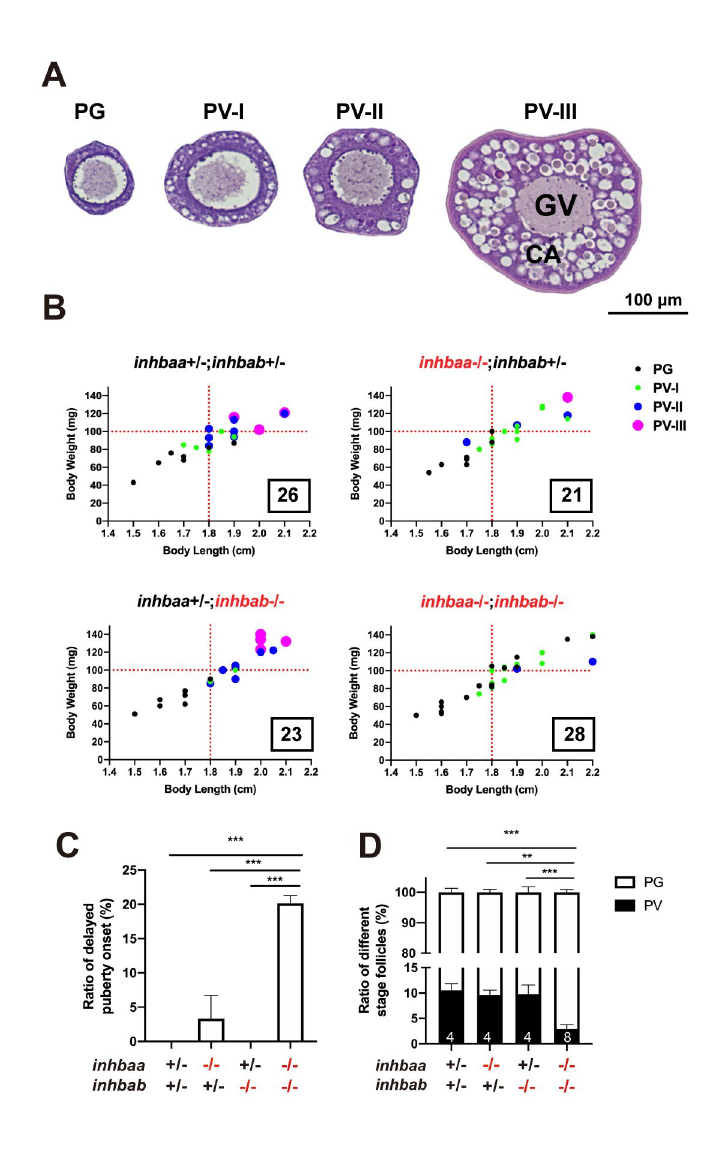
Fig 4. Quantitative analysis for delayed puberty onset in activin β A double mutant ( inhbaa -/-; inhbab -/-). (A) Classification of PV follicles. The PV stage is further divided into three sub-stages according to size and layer number of the cortical alveoli (CA). PV-I, single layer of small CA; PV-II, single layer of large CA; PV-III, multiple layers of large CA. (B) Correlation between PG-PV transition and body size [BL (cm) and BW (mg)]. Dots in different color and size represent different stages of follicles. The number in the box indicates the sample size. (C) Ratios of delayed puberty onset in different activin β A mutants at 45 dpf (n = 3 batches). (D) Follicle composition in the ovary of β A mutants at 45 dpf. Sample size is indicated at the bottom of each column. ( �� P < 0.01; ��� P < 0.001). PG, primary growth; PV, previtellogenic; GV, germinal